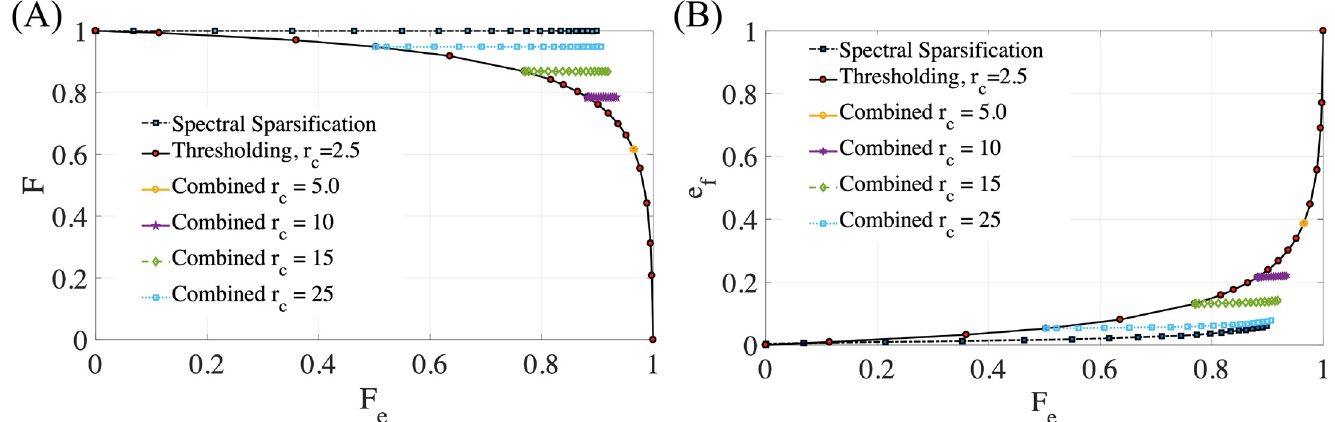
Fig 2. Evaluation of the Coulomb potential on total forces and force errors versus edges removed. (A) Net force vs. fraction of edges removed for thresholded, sparsified, and the combined algorithm. (B) Normalized error vs. edges removed for thresholded, sparsified, and the combined algorithm.